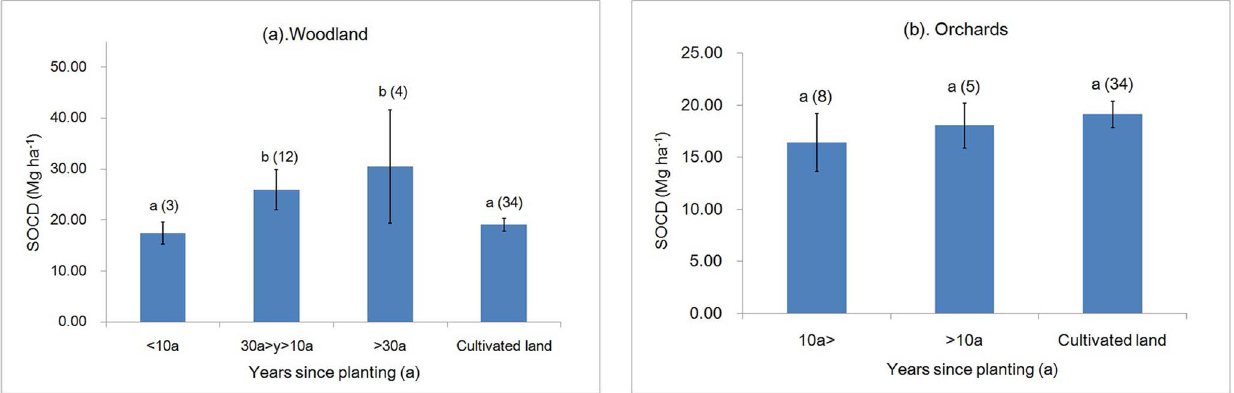
Figure 3. Relationship of years since planting and topsoil SOCD. * The error bars are the standard errors of the mean of SOCD and values above the bars is the number of observations (in parentheses). A different letter means a difference significant at P ,